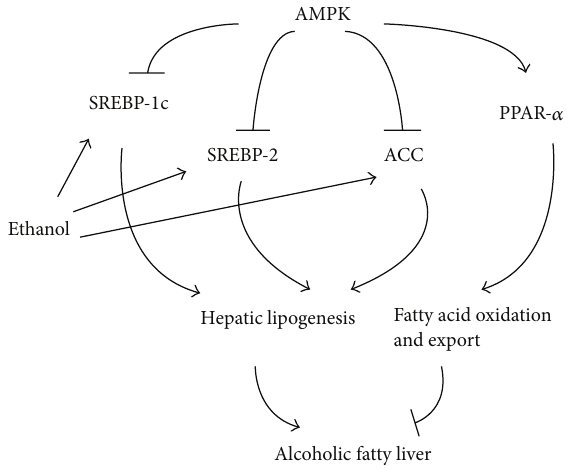
Figure 1: Effect of ethanol treatment on the AMPK-related lipid metabolismpathway.SREBP:steroidresponseelement-bindingpro- tein; AMPK: adenosine monophosphate-dependent protein kinase; PPAR- 𝛼 : peroxisome proliferator-activated receptor alpha; ACC: acetyl-CoA